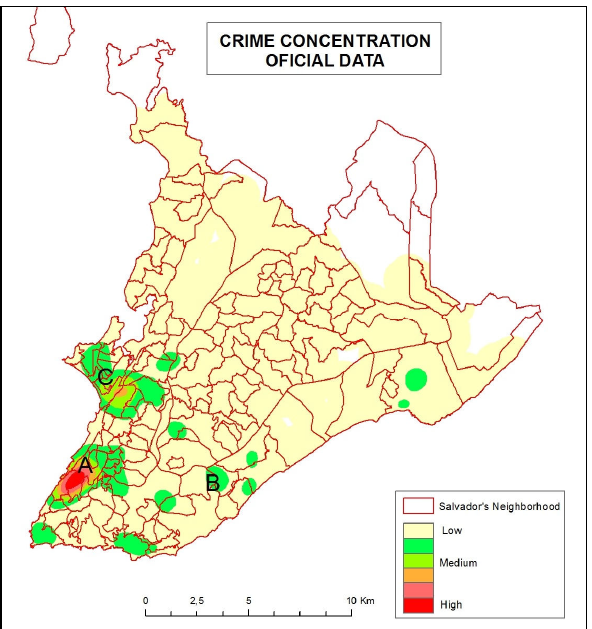
Figure 4. Map of concentration of crimes to the transient reported to official police agencies.